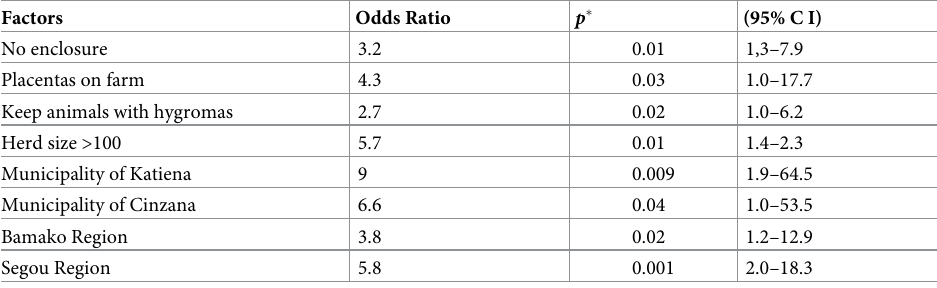
Table 4. Risk factors for animal contamination.